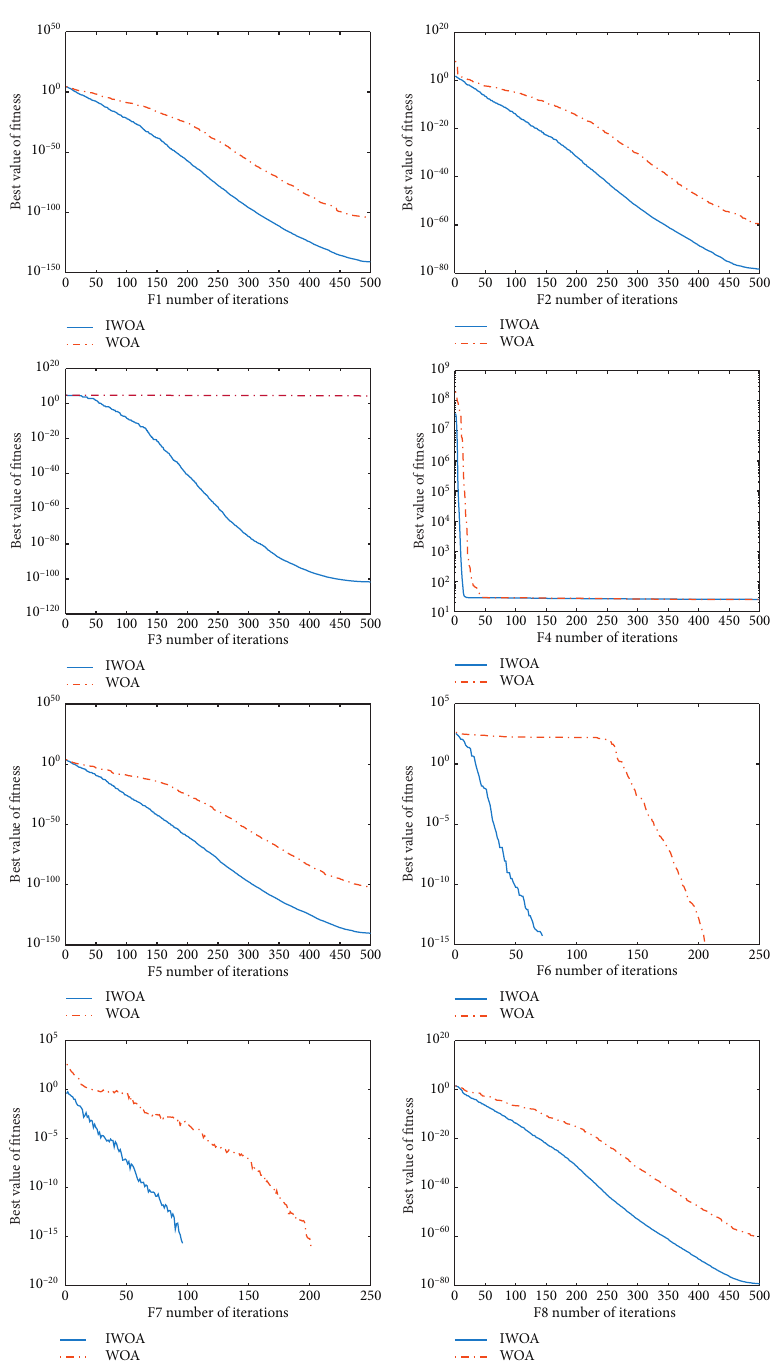
Figure 5: The evolution curve of finding the optimal solution of equation F1–F8. Table 3: Comparison of IWOA with other